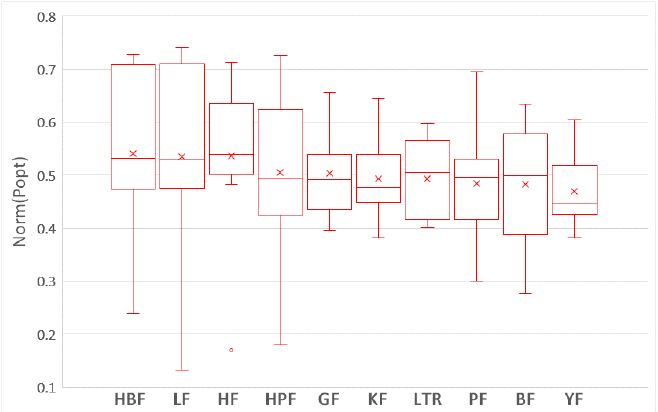
Figure 8. The boxplots of nine training data selection methods and LTR trained on 10% WP data with the Scott–Knott test results in terms of